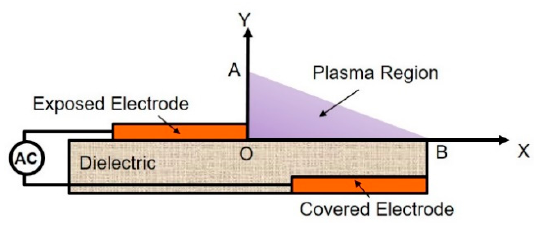
Figure 4. Sketch of the plasma actuator.